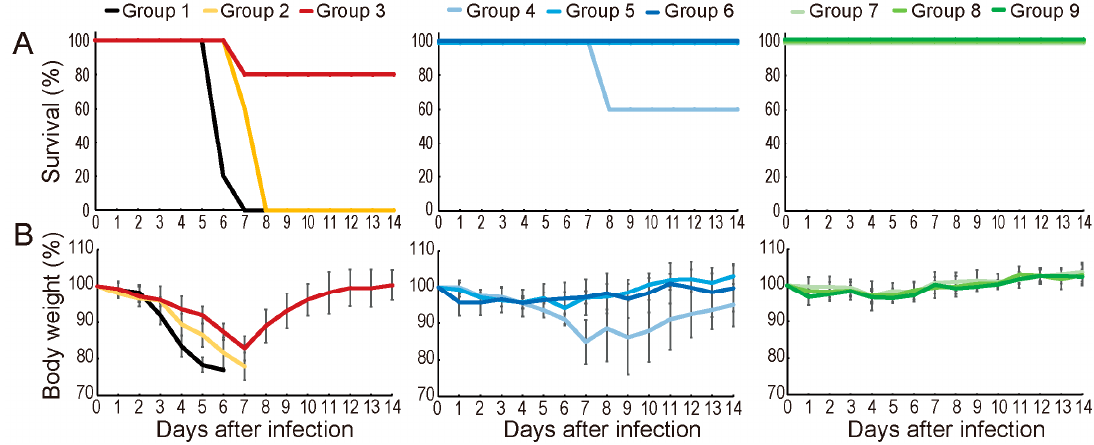
Figure 2. Treatment of infected mice with baloxavir marboxil. Mice were intranasally infected with 10 MLD 50 of a highly pathogenic H7N9 virus. Five mice per group were treated as described in Table 1. Survival ( A ) and body weight changes ( B ) were monitored for 14 days post infection. Mouse body weights are expressed as mean ± SD.